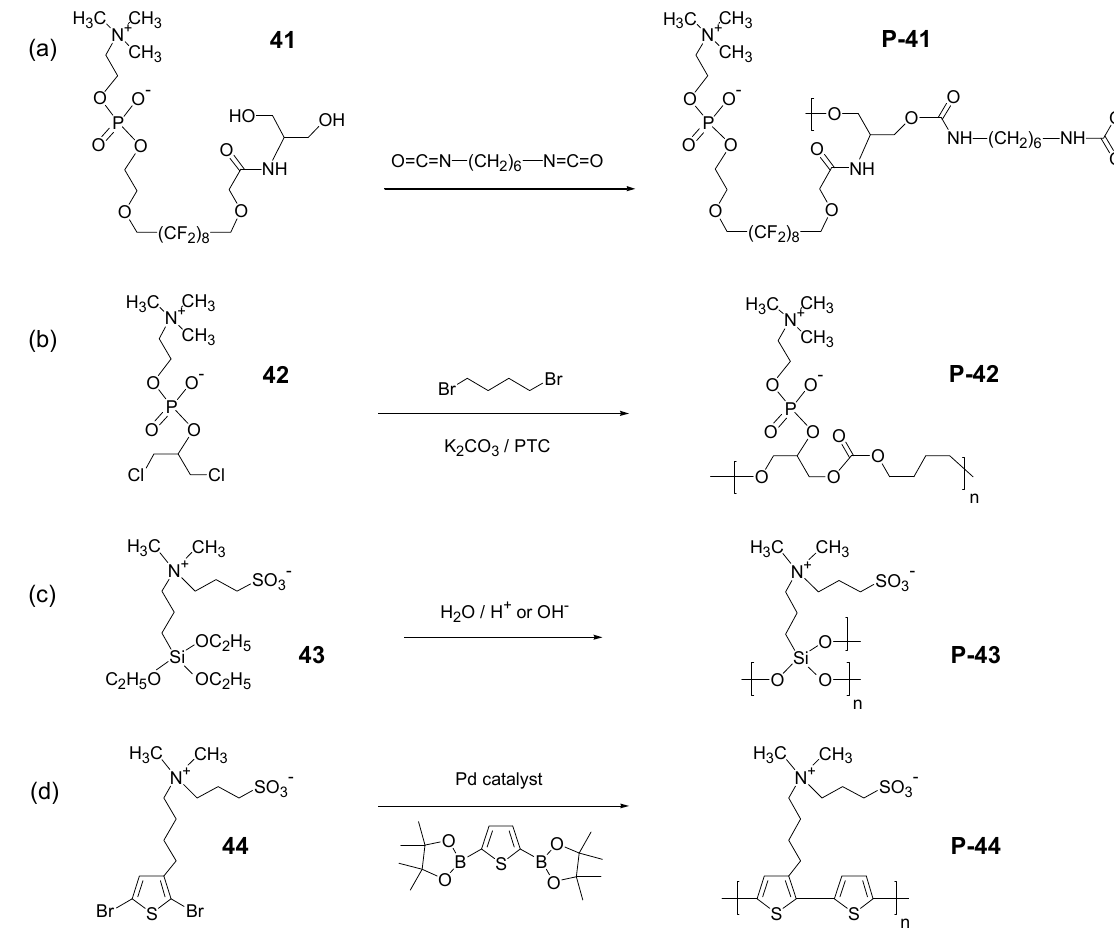
Figure 7. Examples for polyzwitterions produced via step growth polymerization: ( a ) polyurethanes [376]; ( b ) polycarbonates [380]; ( c ) polysiloxanes[381]; ( d ) conjugated backbones